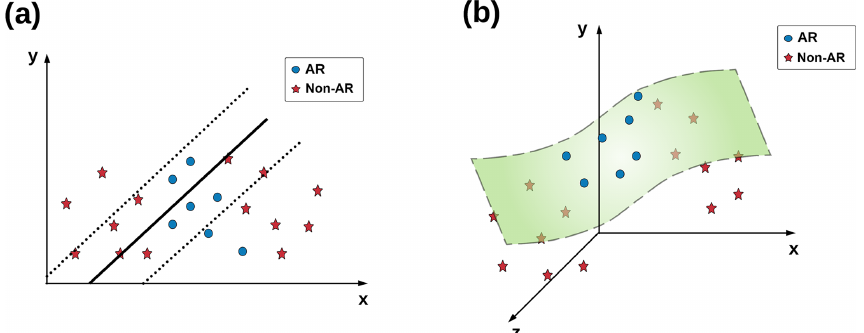
Figure 8. (a) An example of no clear linear separation between two classes (e.g., ARs and non-ARs) in data. This case cannot be solved using linear SVM. (b) In a situation where the set of two class samples is not linearly separable in the original space, the SVM introduces the notion of a “kernel-function-induced feature space” which casts the data into a higher-dimensional space where the data are separable.